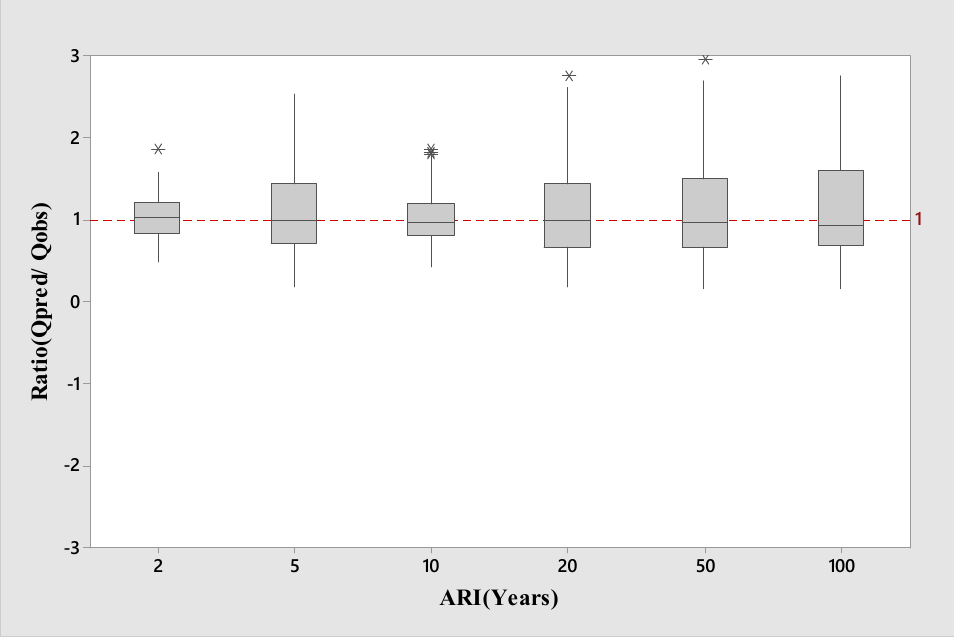
Figure 3. Boxplots of Q pred / Q obs ratio values for log-log linear model of combined group (* represents outliers).